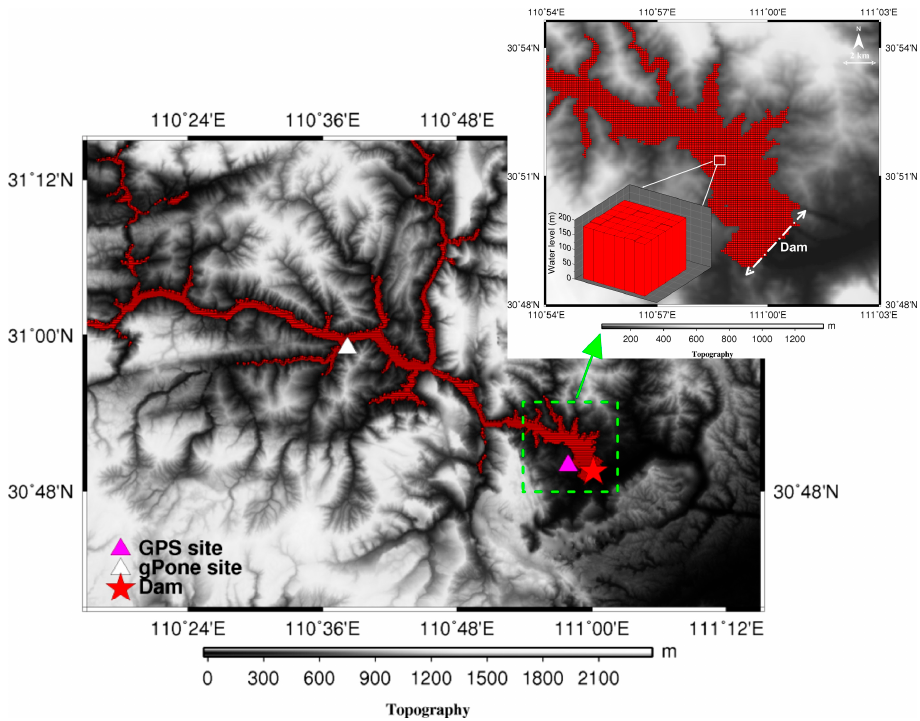
Figure 2. Water volume distribution (a portion of the loading model near the dam) used for numerical simulation. The effective water surface is determined by the difference between bed elevation and the water level (i.e., 175 m). The locations of in-situ A10, gPhone, and GPS measurements are shown as yellow dots, white triangle, and pink triangle,